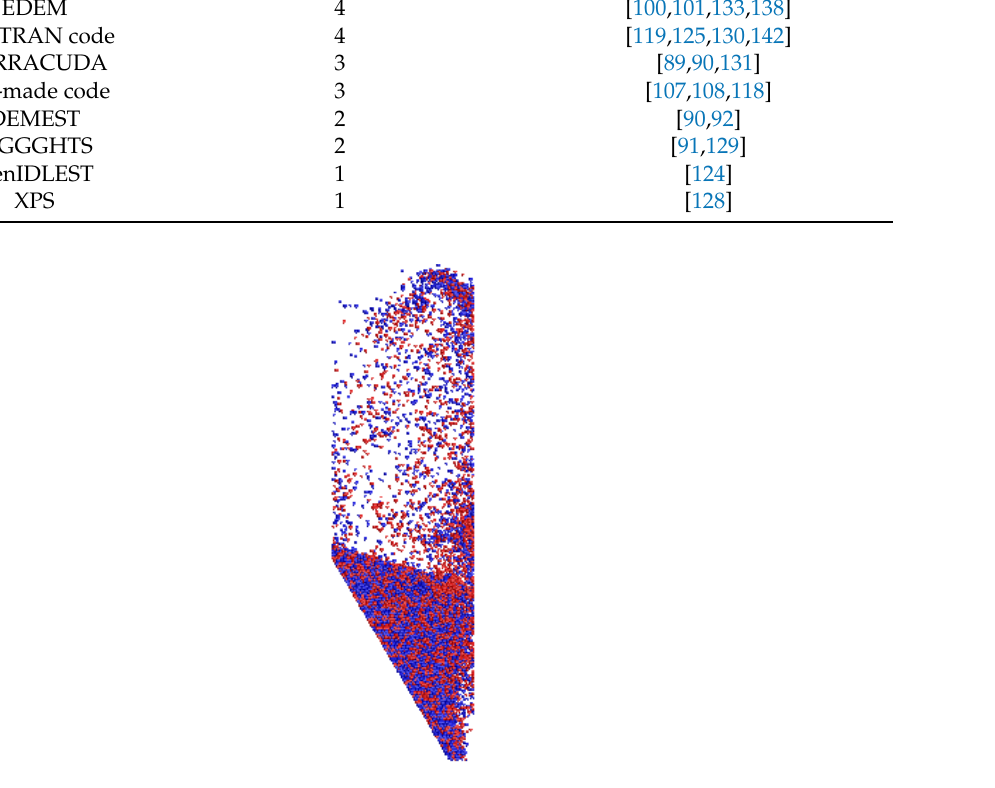
Figure 5. Spouting of a binary mixture of glass particles in ANSYS FLUENT 17.0. Table 2. Software used for DEM modelling in SB.